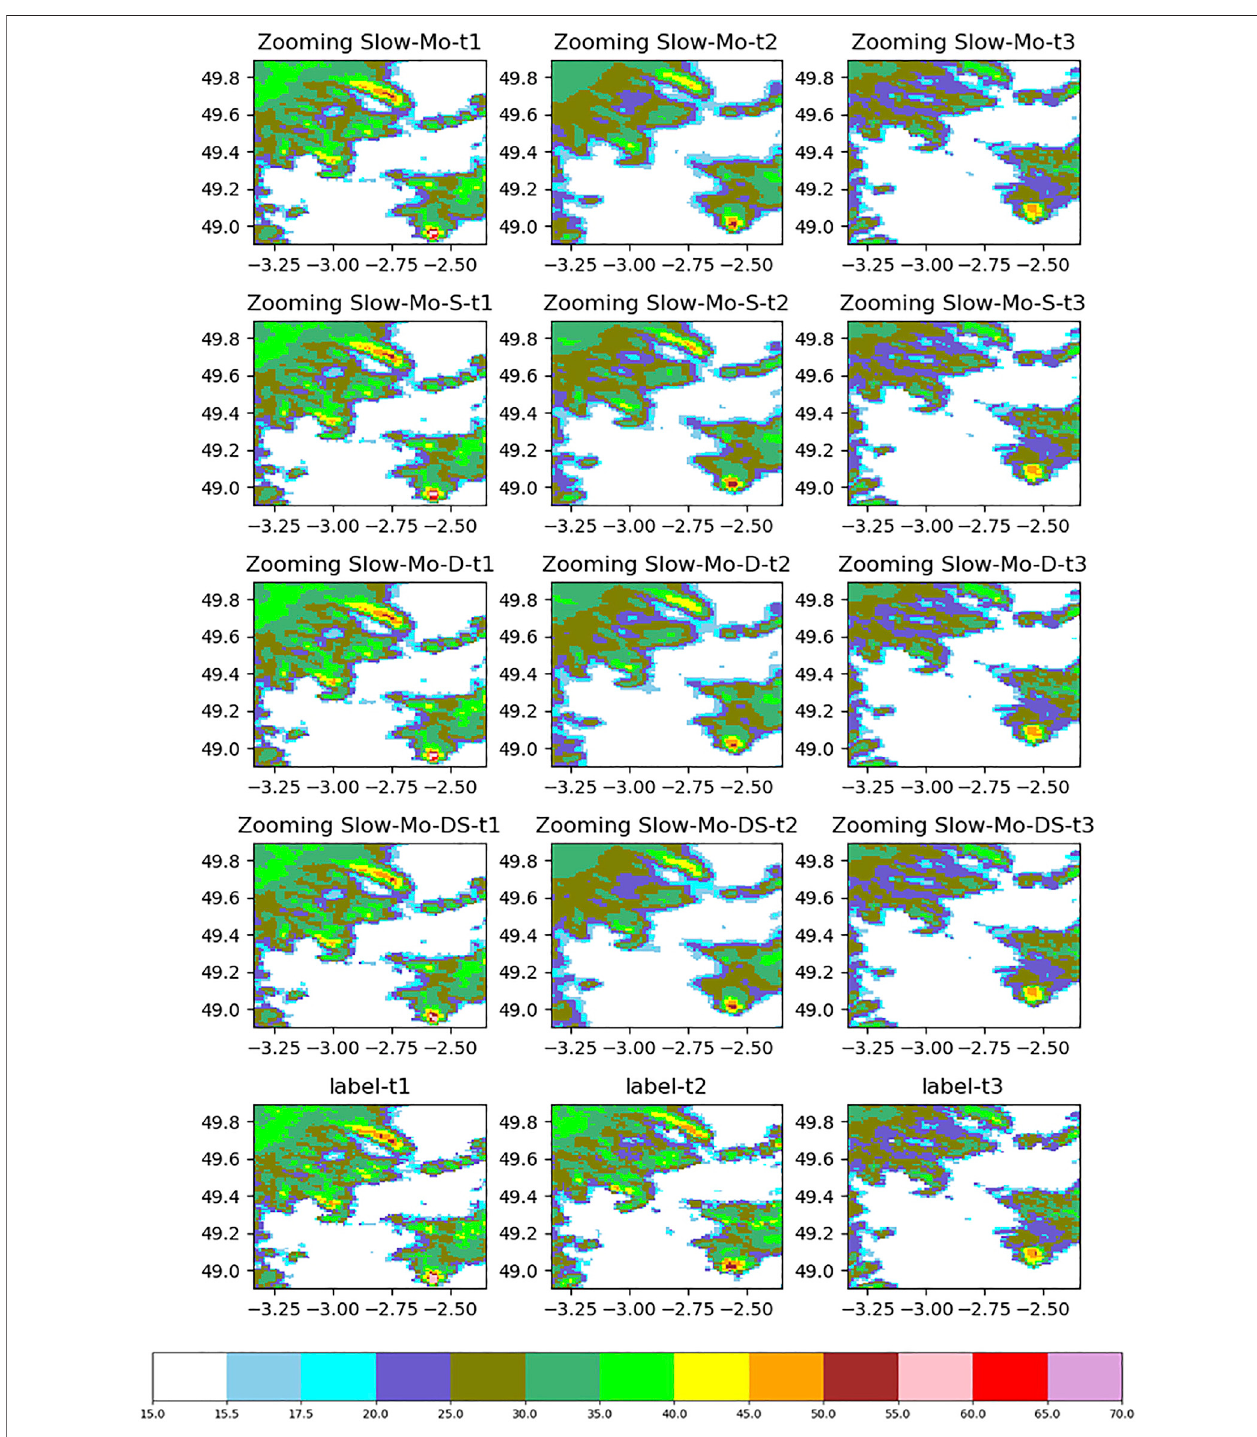
FIGURE 11 | Precipitation re fl ectance